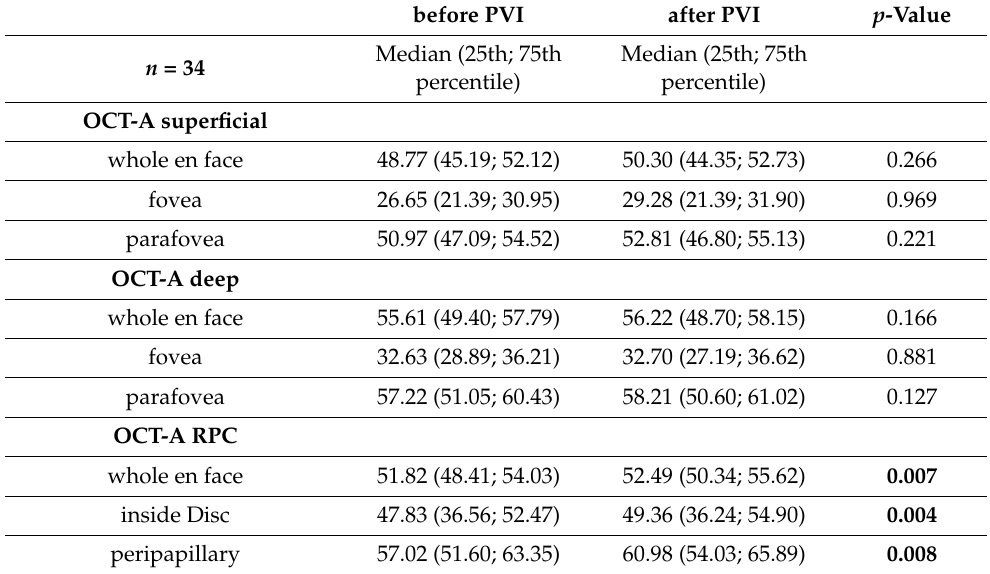
Table 3. Values of flow density (%) before and after PVI obtained in the regions indicated. Bold: statistically significant differences. PVI = pulmonary vein isolation.